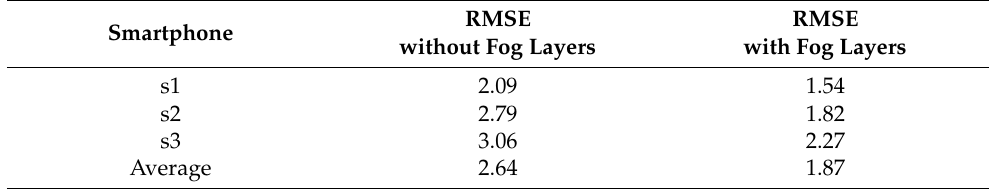
Figure 7. Speed estimation using smartphone 1, which shows a comparison of estimation between the baseline (edge computing alone) and the proposed system (edge + fog layers). The proposed system’s estimation is more accurate than that of the baseline.